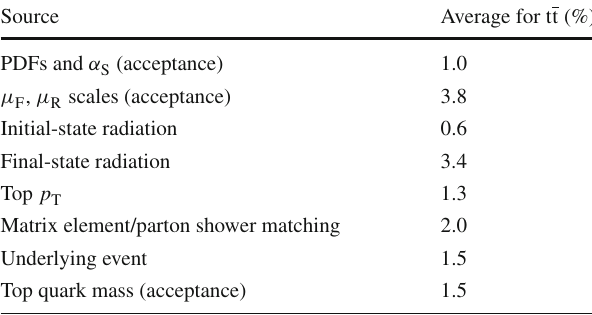
Table 2 Summary of the contribution of each modeling uncertainty source to the DNN score distribution for the tt